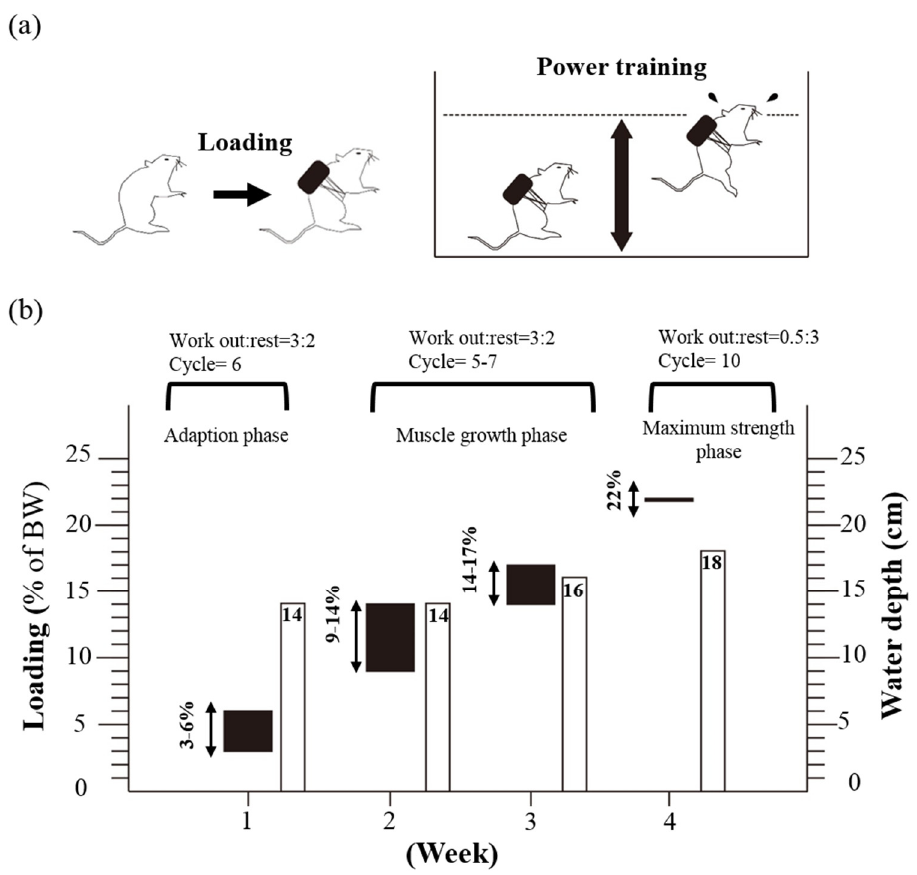
Figure 1. Protocol for 4 ‐ week power exercise training (PET). ( a ) Mice were placed in a plastic